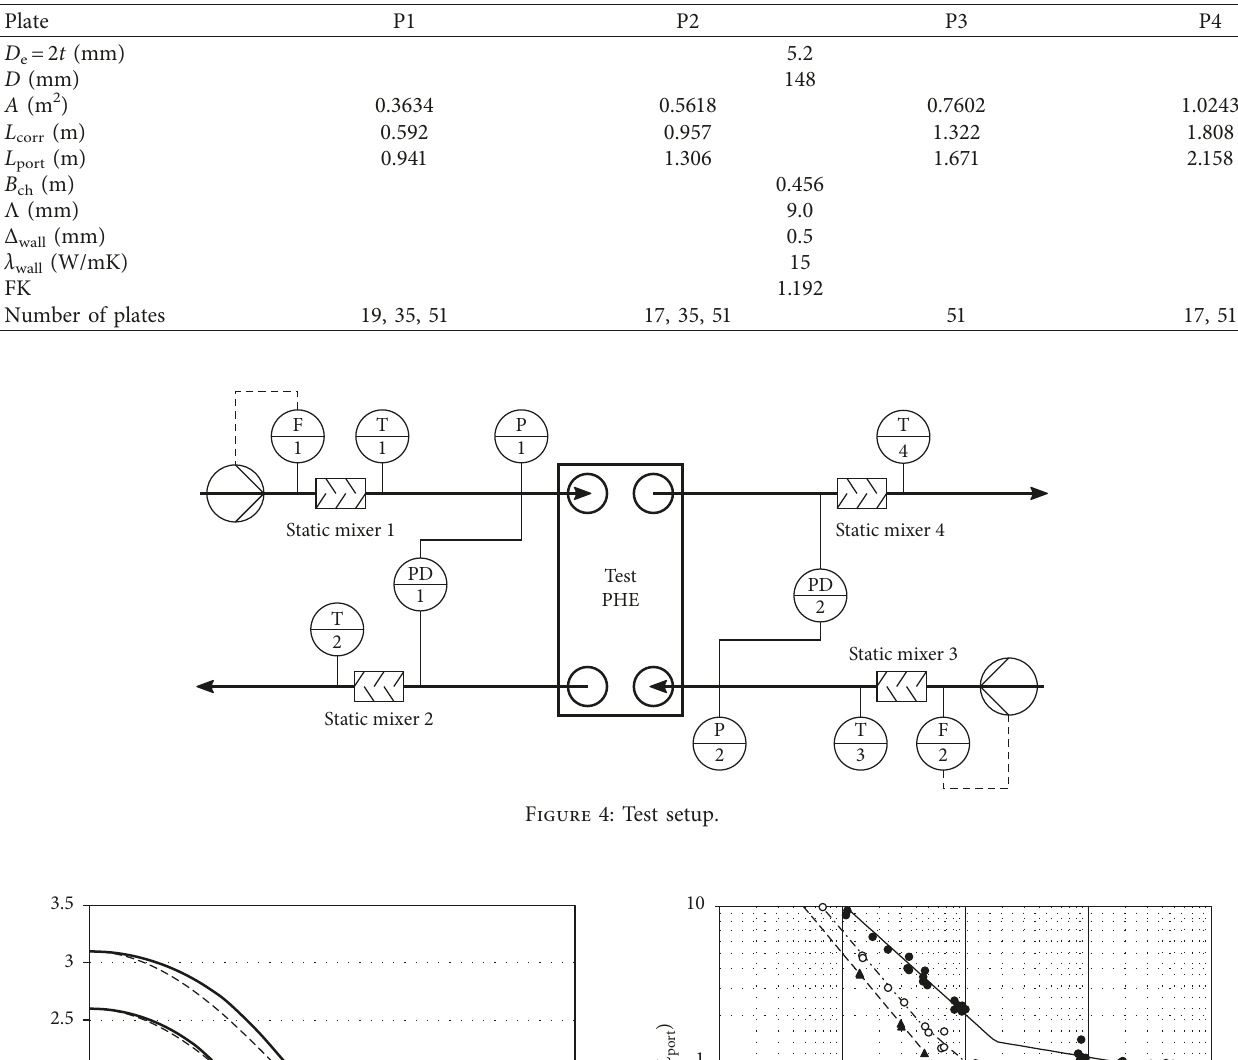
Table 1: Chevron plate characteristics.